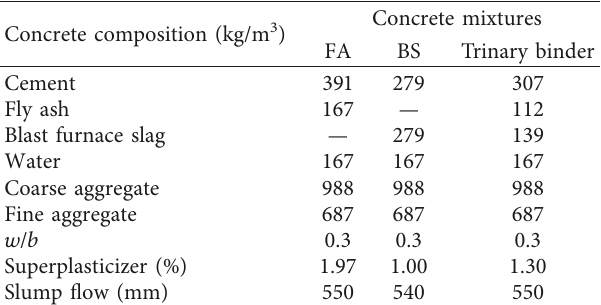
Table 3: Concrete mixture proportions.